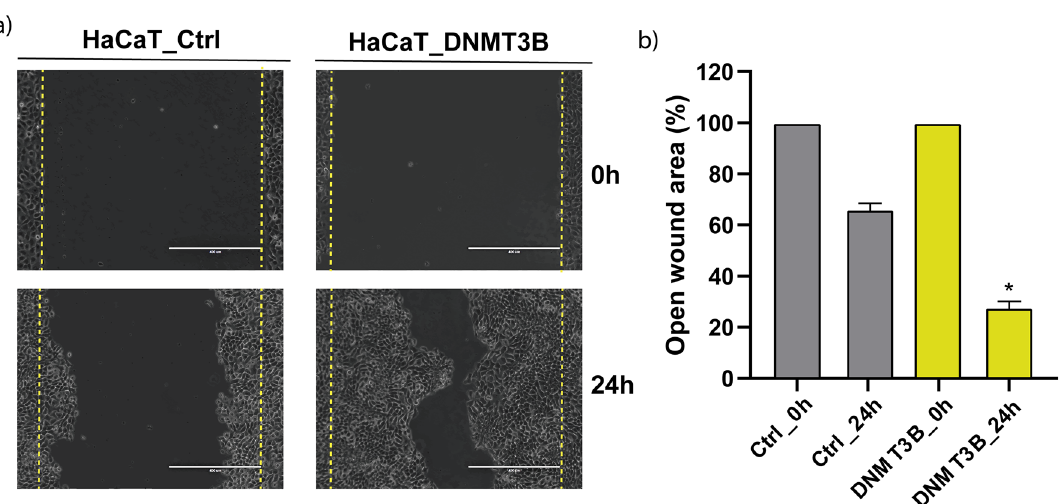
Figure 6. DNMT3B overexpression increased the cell migration. ( a ) Cell migration evaluated by wound closure assays at 0 h and 24 h in control HaCaT and HaCaT with DNMT3B overexpression. ( b ) Quantification of the open area of the wound presented in percentage in each condition. The image is representative of three independent experiments in